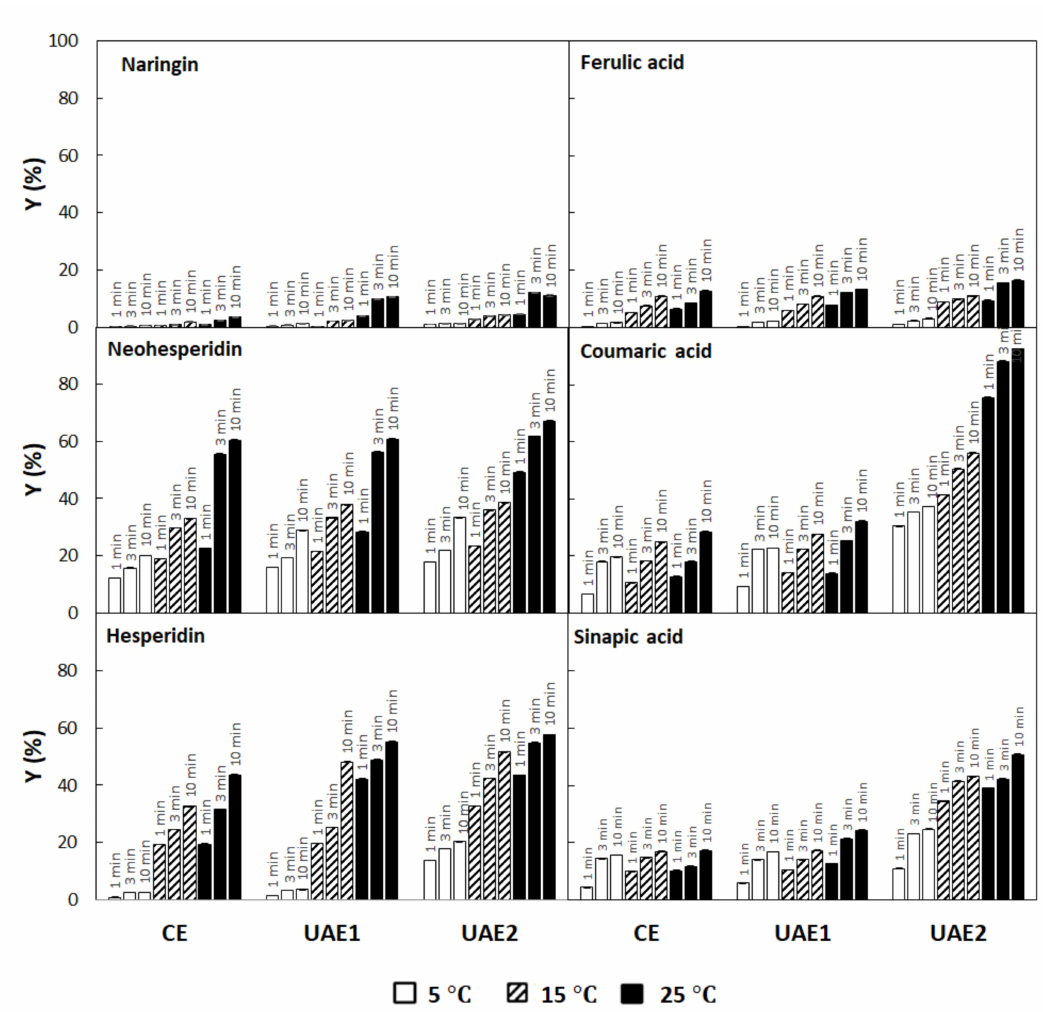
Figure 2. Extraction yields of flavonoid compounds (naringin, neohesperidin, and hesperidin) and phenolic acids ferulic acid, -coumaric acid, and sinapic acid) extracted during 1, 3, and 10 min from orange byproduct by conventional extraction (CE) and ultrasound-assisted extraction with two ultrasonic powers (UAE1 at 520 W / L; UAE2 at 790 W / L). Di ff erent lowercase letters for the same extraction process and same temperature indicates significant di ff erences in